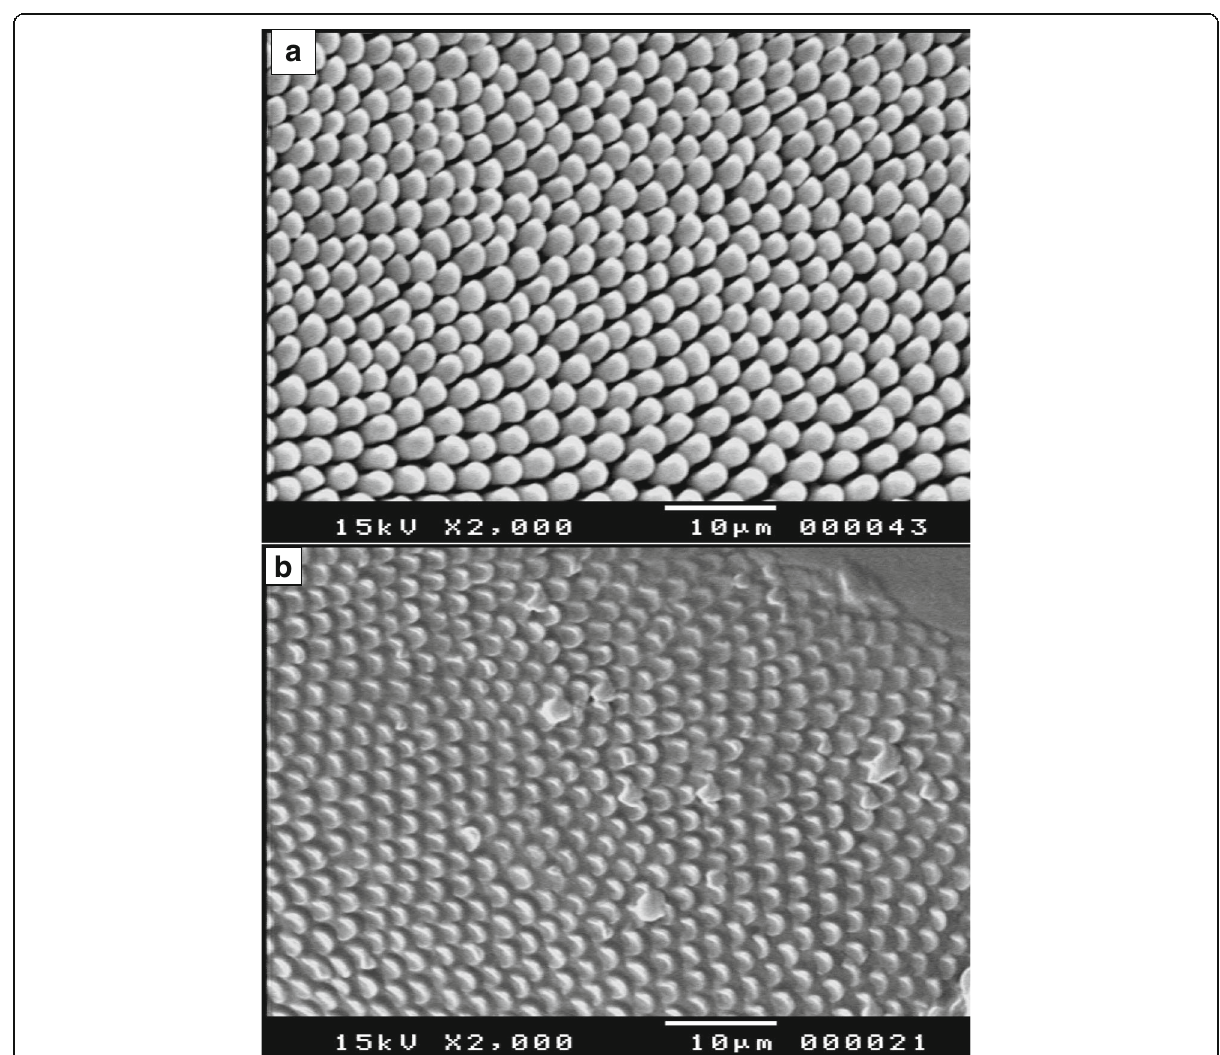
Fig. 3 Scanning electron microscope (SEM) images of microtrichia on the ventral surface of elytron of Tribolium castanaeum ( a ) and Tribolium confusum ( b